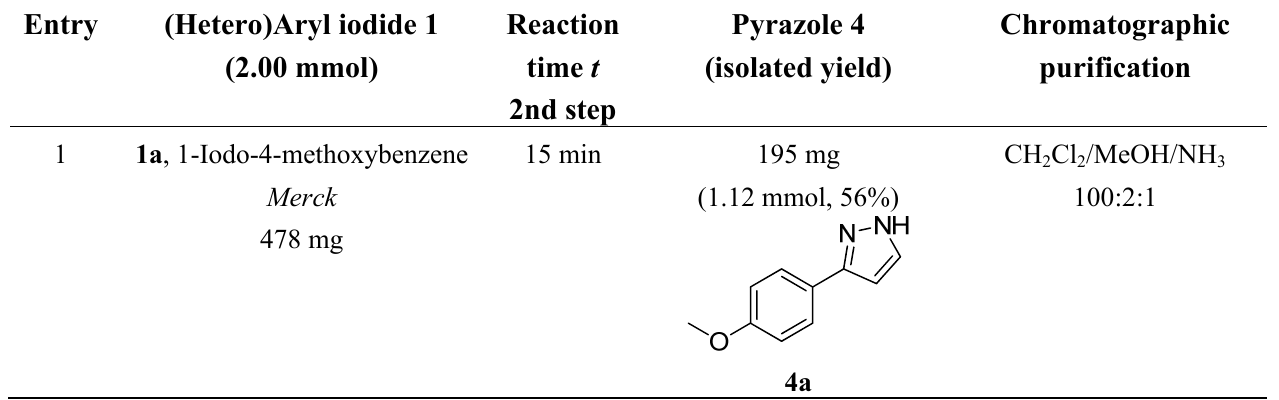
Table 4. Synthesized 3-substituted 1 H -pyrazoles 4 via alkynylation-cyclocondensation